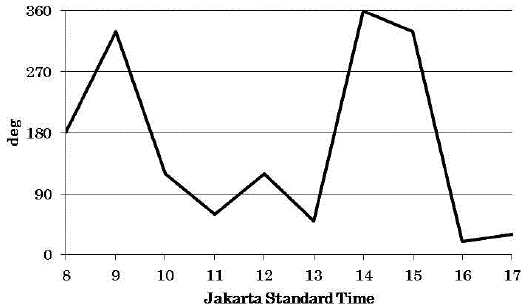
Fig. 5 Wind direction on 16 September at the Halim Airport observatory. Here, 0° (360°) indicates northward wind, and 180° indicates southward wind.